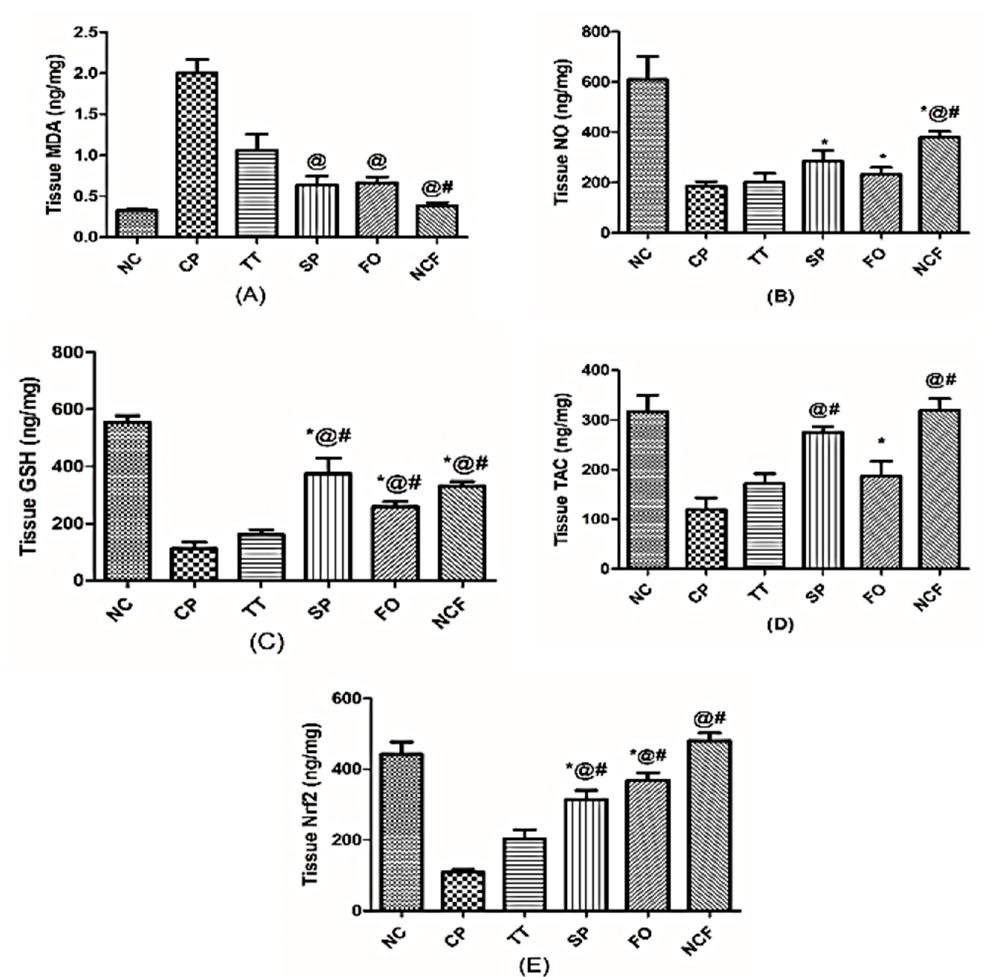
Figure 12. Effect of TT, SP, FO, and NCF on cisplatin-induced alterations in testicular oxidative stress and antioxidant markers in adult male rats. Effect of 20 days administration of TT (100 mg/kg/orally); SP (1000 mg/kg/orally); FO (400 mg/kg/orally); and new nutraceutical formula (NCF) at a dose of (4.4 g/kg/orally) on testicular content of ( A ) MDA, ( B ) NO, ( C ) GSH, ( D ) TAC, and (E) Nrf2 in CP-untreated rats. Values are means of 6-10 rats ± SD. Statistical analysis was performed using one-way ANOVA followed by Newman Keuls multiple comparison tests ( p < 0.05). As compared with normal control (NC; *), cisplatin (CP; @), Tribulus terrestris (TT; #). Spirulina platensis (SP), Fish oil (FO), malondialdehyde (MDA), reduced glutathione (GSH); total antioxidant capacity (TAC), Nuclear Factor [Erythroid-Derived 2]-Like 2